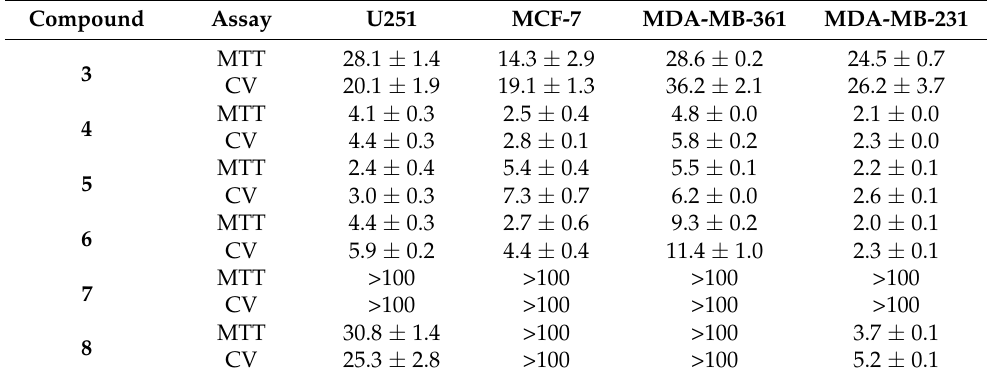
Table 2. IC 50 values ( µ M) of compounds 3 − 8 from MTT and CV assays after 72 h incubation shown as mean together with one standard deviation (mean ± SD). Compound 3 served as reference. Compound Assay U251 MCF-7 MDA-MB-361 MDA-MB-231